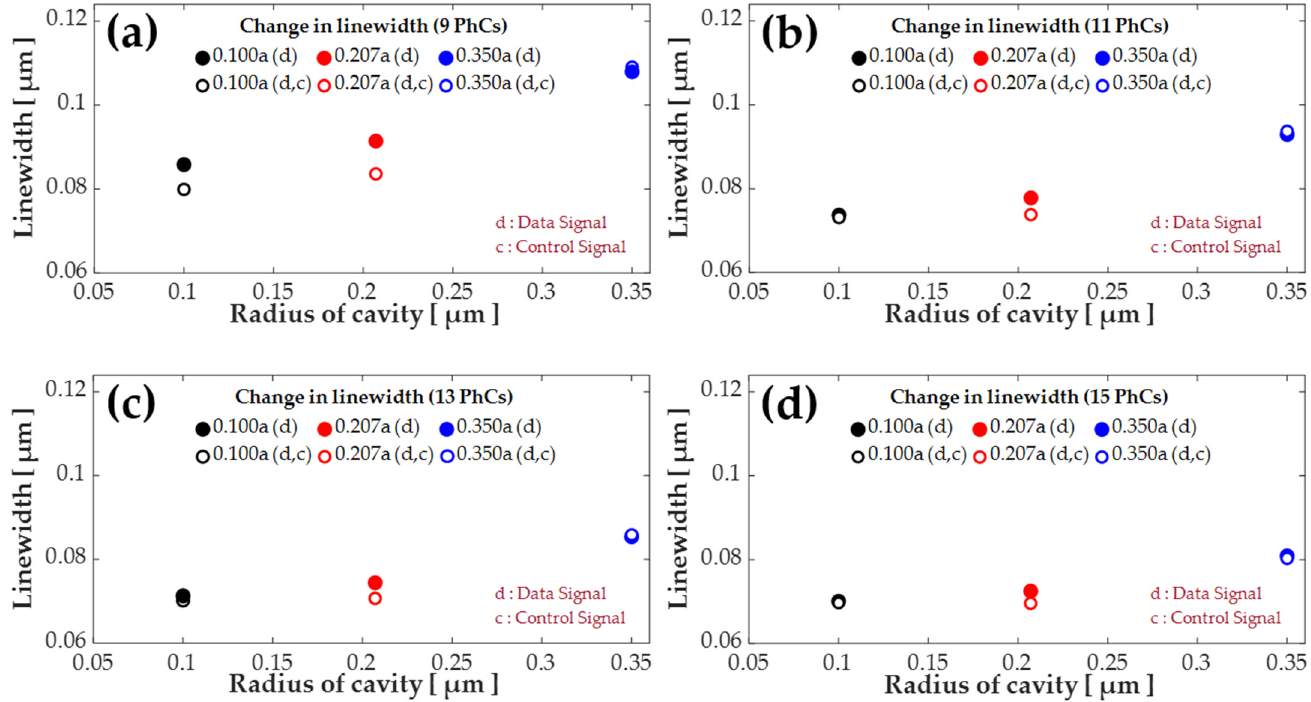
Figure 11. Variation in the linewidth of resonant modes in optical switching action for different numbers of PhC-elements and change in cavity-radius. Single source signal shown in sold circles and dual source signal with hollow circles. ( a ) 9 PhC-elements ( b ) 11 PhC-elements ( c ) 13 PhC-elements ( d ) 15 PhC-elements.